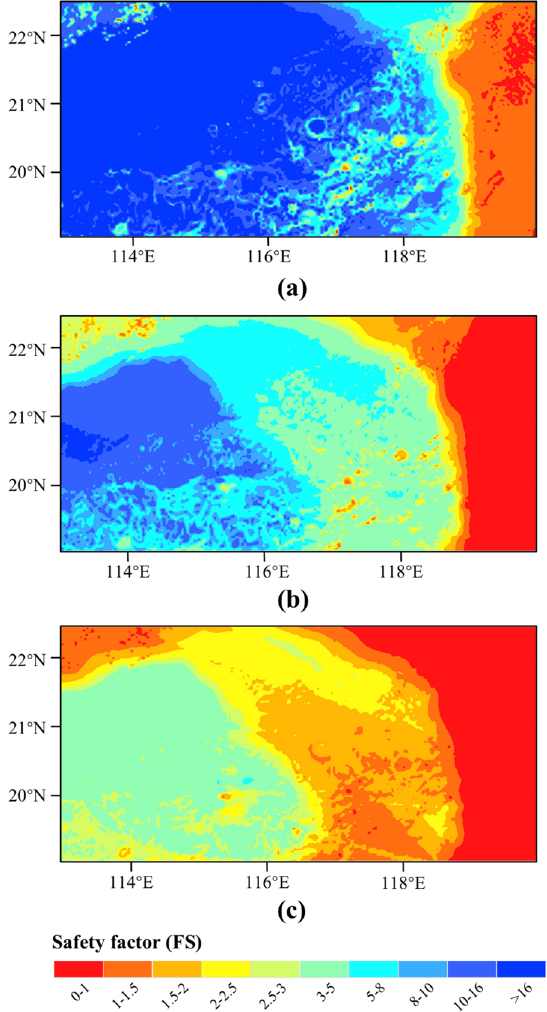
Fig. 22 FS of seabed stability in the SCS under different earthquake exceedance probabilities: a 63% in 50 years; b 10% in 50 years; c 2% in 50 years (modified from Wang et al.